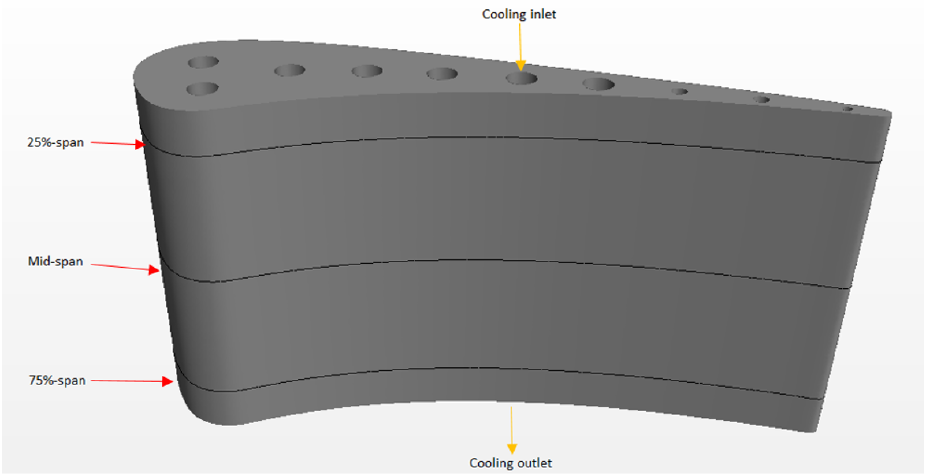
Figure 8. Location of the three cross-sectional planes used for